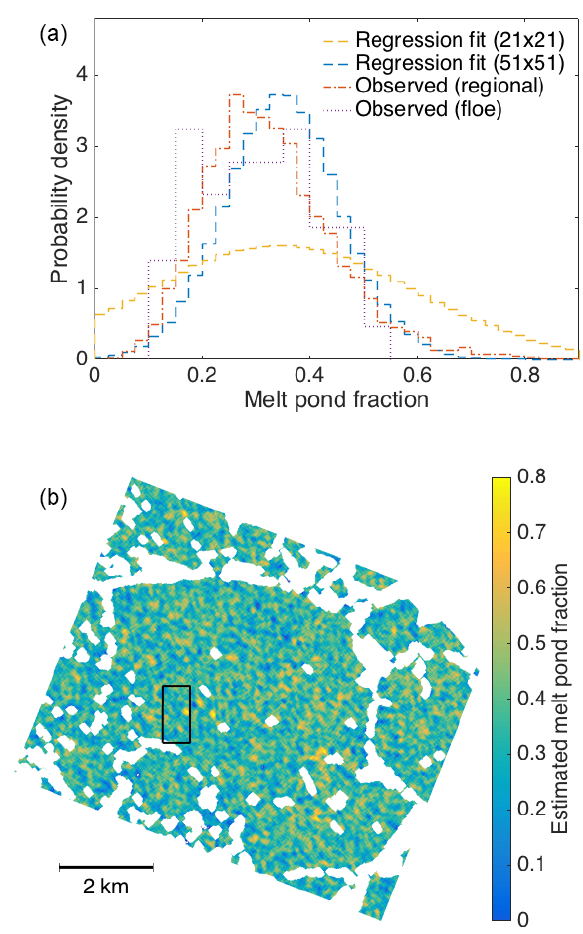
Figure 5. Top: probability density distributions of f MP for the in- vestigated floe in T3. Curves represent distributions produced by the regression fit based on R VV / HH with 21 × 21 and 51 × 51 pixel windows, and observed distributions from all helicopter flights (re- gional) and from the specific floe (floe). Bottom: estimated f MP from the R VV / HH based regression with a 51 × 51 pixel window for investigated floe in T3. The frame outlines the area displayed in Fig.